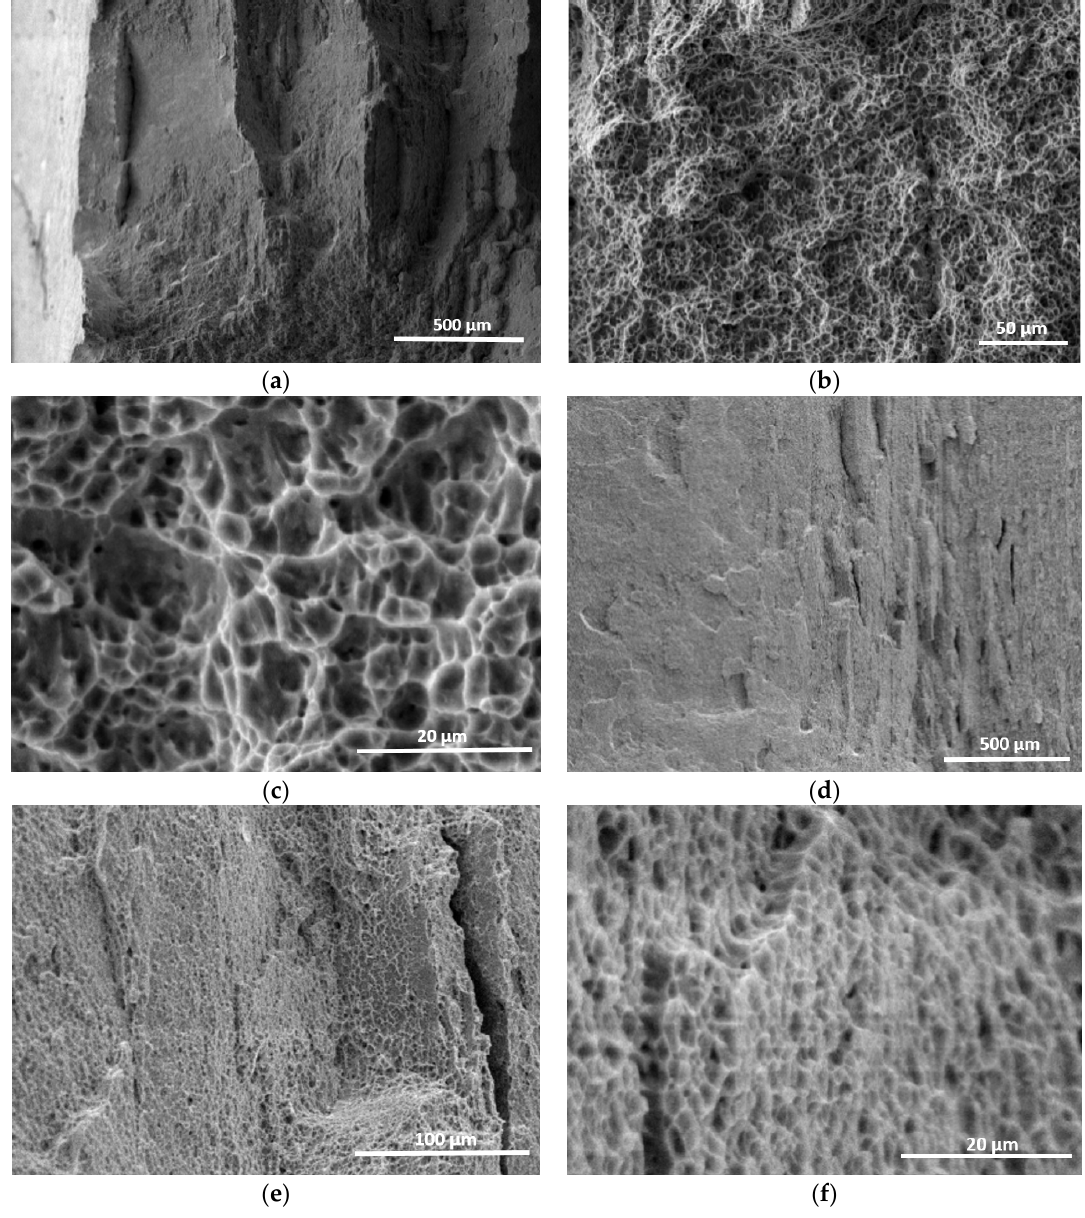
Figure 9. Fractograms of the fracture surface of the specimen from the VT23M alloy subjected to static stretching, 33y ( a – c ) and to DNP, 5y ( d – f ).